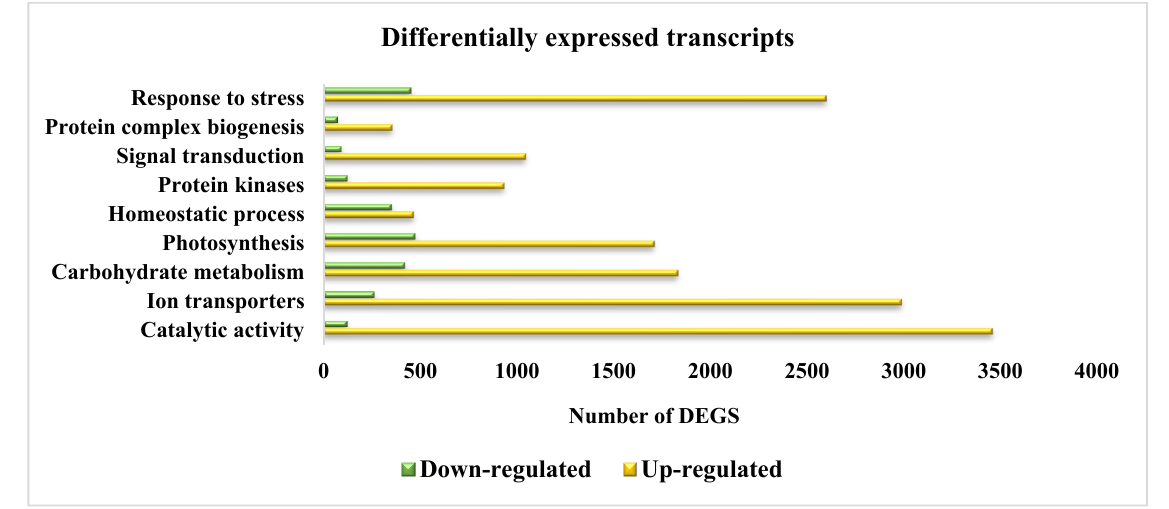
Figure 14. Most highly represented pathways in Sorghum bicolor.